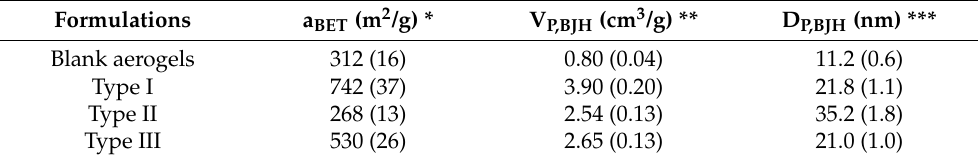
Figure 3. Blank 0.75% ( w/v ) alginate aerogels ( a , b ); type I aerogels ( c , d ); type II aerogels ( e , f ); type III aerogel ( g , h ) structures. In higher magnification images, porous structure is observed in all formulations. Table 2. Textural properties of blank and vancomycin-loaded alginate aerogel microspheres evaluated by nitrogen adsorption–desorption tests. In parenthesis, standard deviation